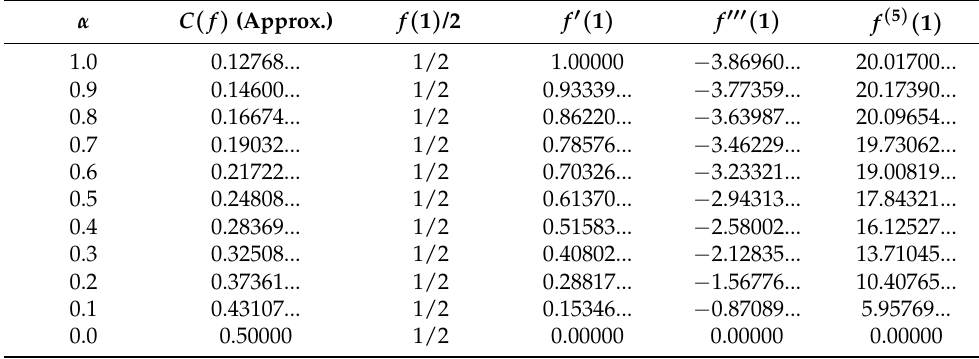
Table 1. Numerical approximations of C (( − 1 ) n − 1 f ) , using Formula (44), evaluated until k = 5, for some values of α > 0 (derivatives).